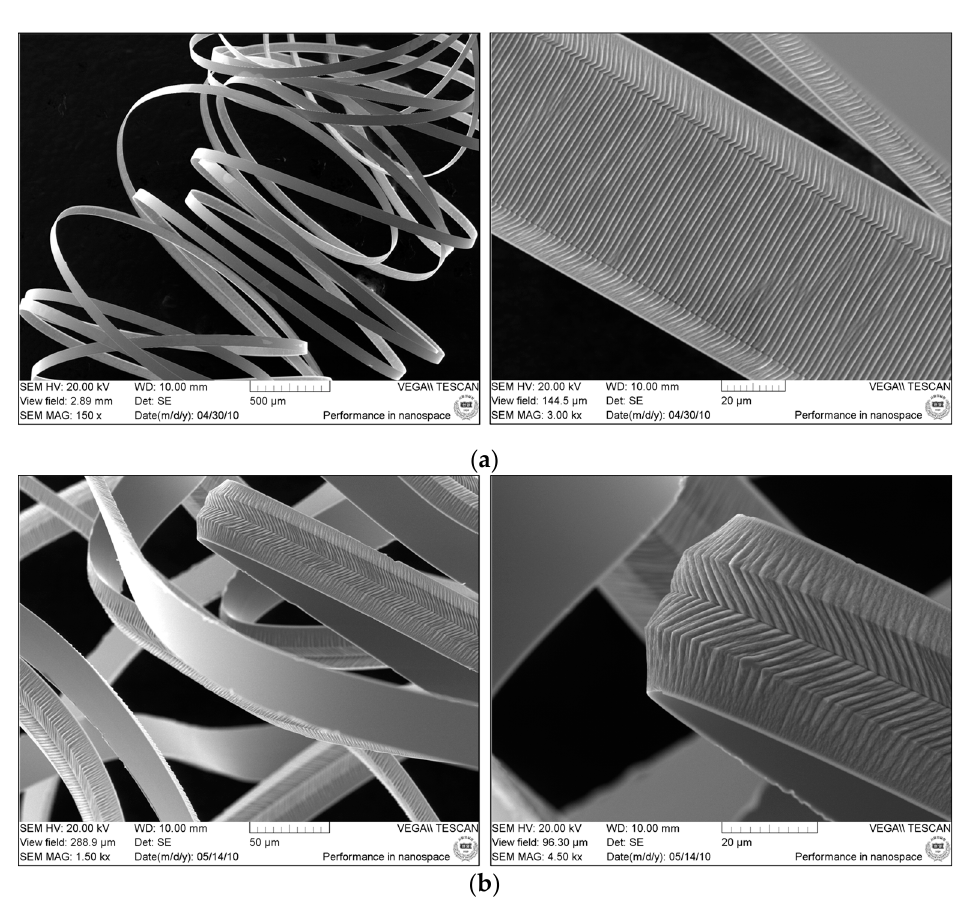
Figure 11. SEM images of the cutting chips: ( a ) cutting chip of the trapezoidal section, ( b ) cutting chip of the V-shaped section.